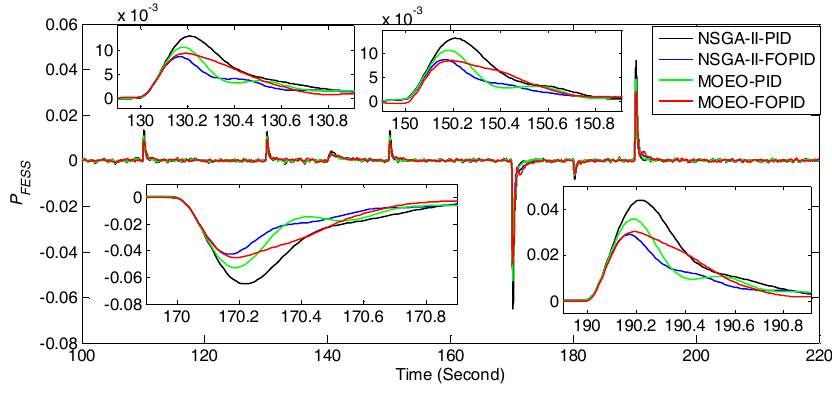
( a ) Power of FESS labeled as P FESS Figure 7.